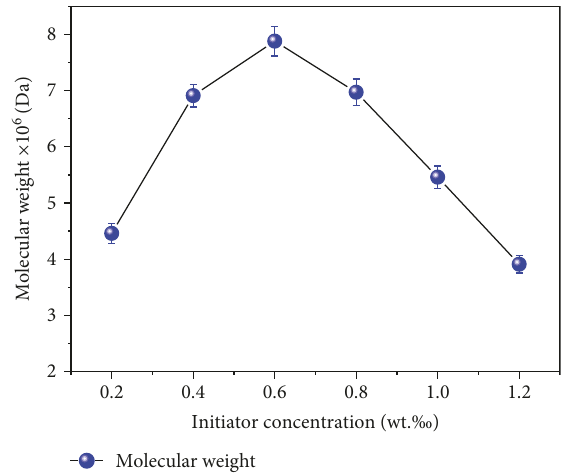
Figure 3: E ff ect of mass ratio on the molecular weight of PAD. Figure 4: E